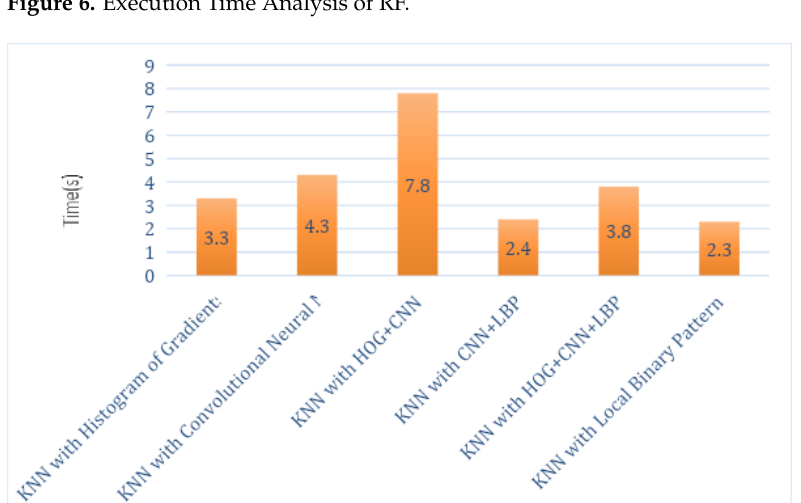
Figure 6. Execution Time Analysis of RF.